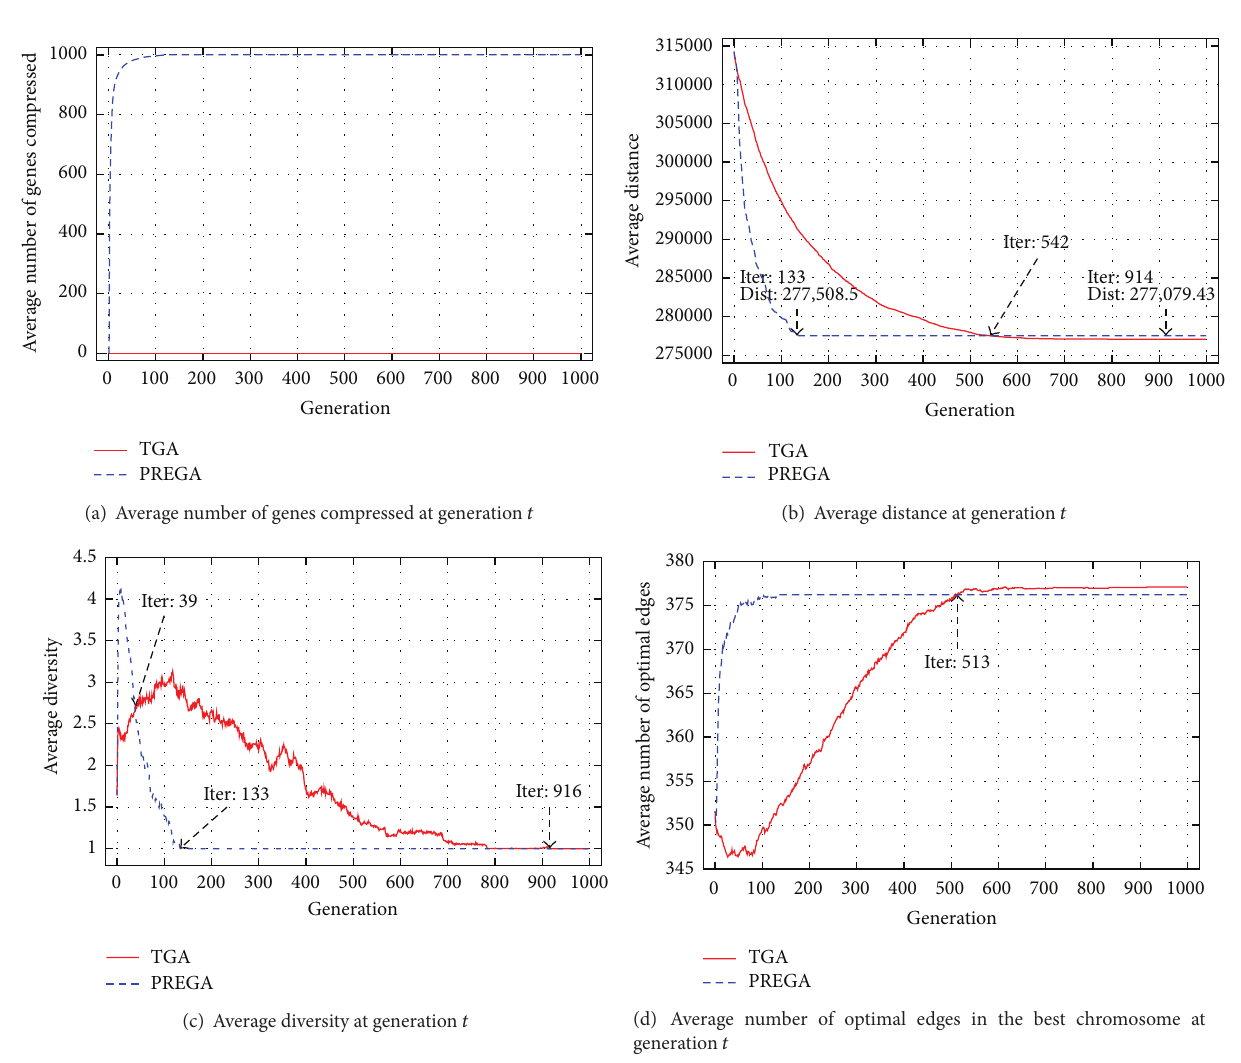
Figure 3: (a) Graphs showing tours encoded in two chromosomes and the outdegree of each city. For instance, the outdegree of city 1 is = 3 . (b) Same information given in (a) represented as an adjacency matrix which makes it easier to understand how the average size of the 𝑑 1 search space is computed. The number 2 in the denominator in (4) indicates that the adjacency matrix is symmetric in this case.